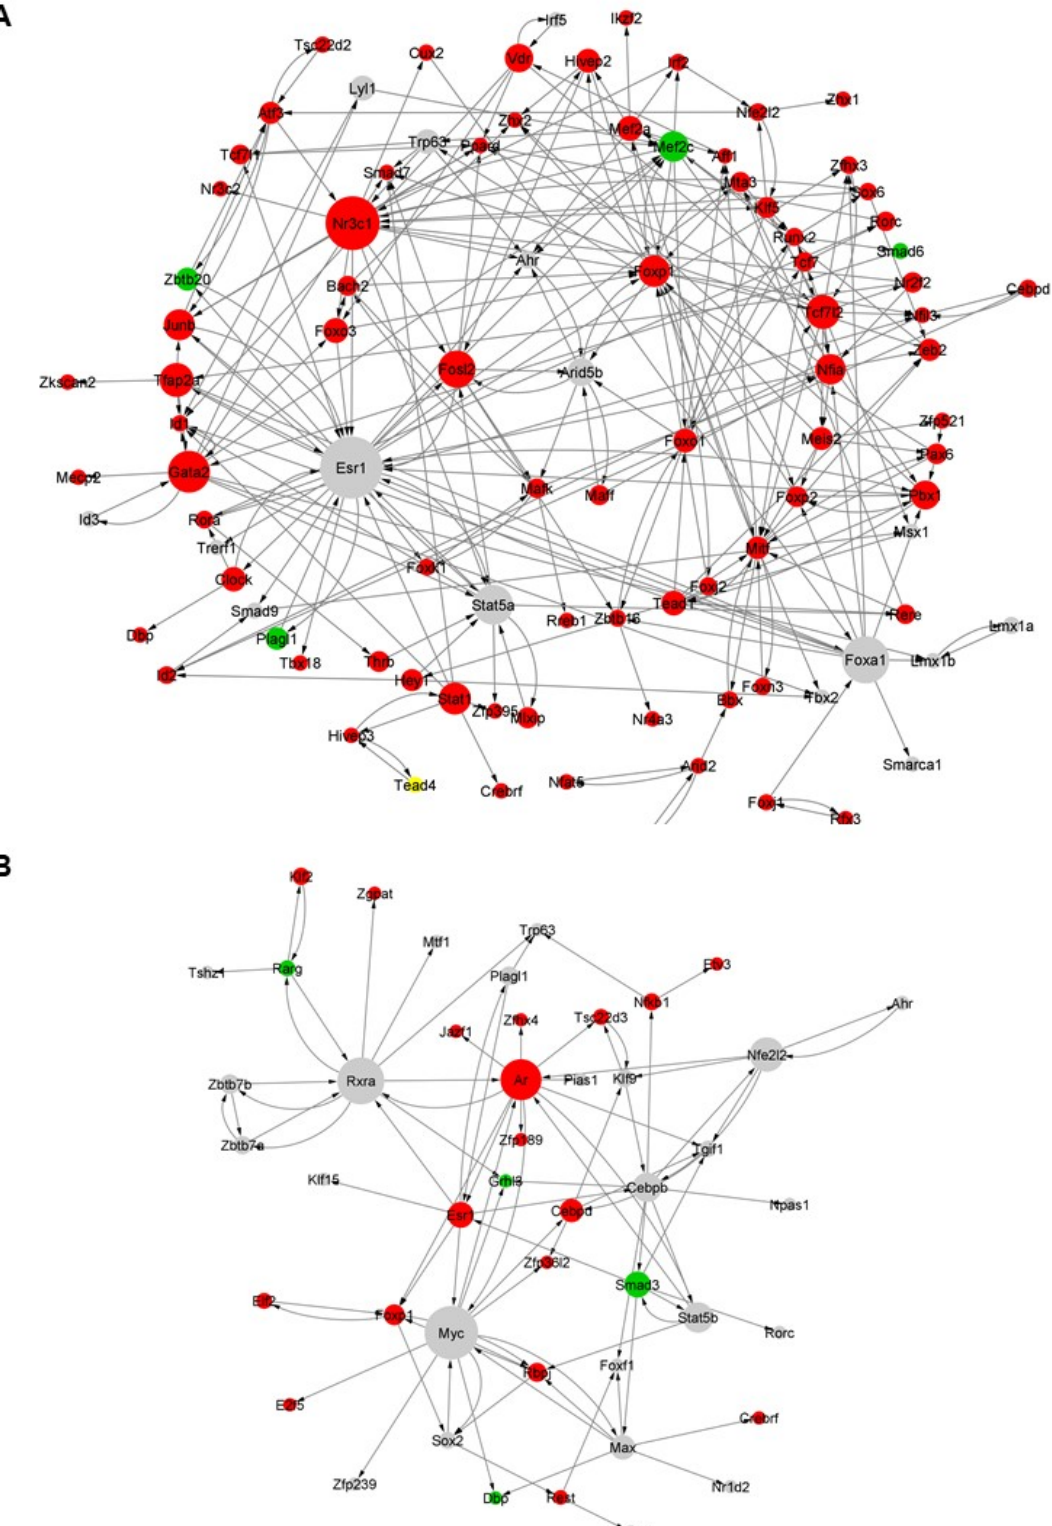
Figure 7. Reconstructed gene regulatory networks under normal conditions. TF-TF regulatory network at ( A ) 24-h and ( B ) 72-h time points. Color legend represents differential accessibility of the TFs (green: upregulated; red: downregulated; grey: not differentially accessible).